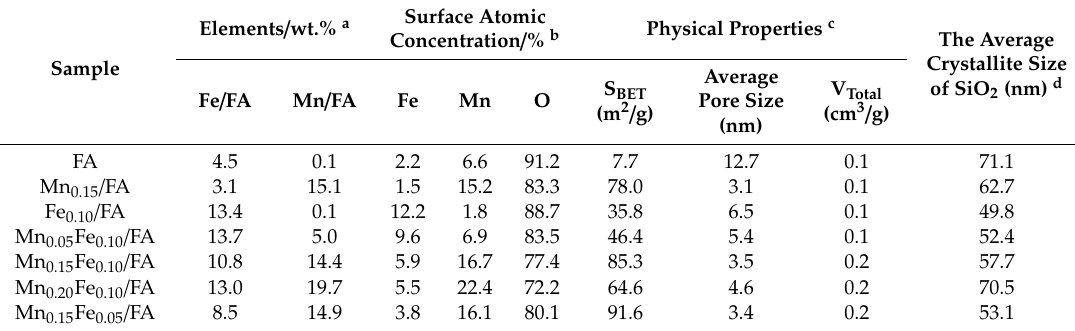
Table 1. Surface species and physical properties of Mn x Fe y / FA